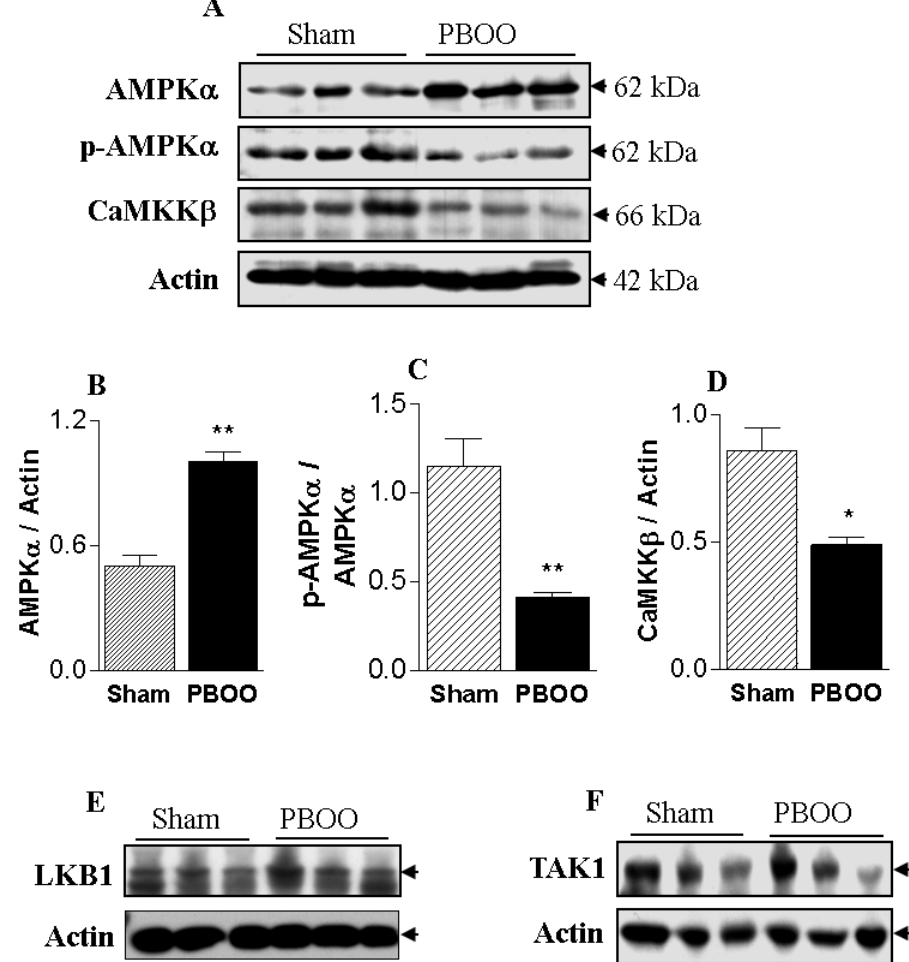
Figure 2. Effect of partial bladder outlet obstruction (PBOO) on AMPKα expression ( A , B ), AMPKα phosphorylation ( A , C ), CaMKKβ expression ( A , D ), and expression and phosphorylation of LKB1 ( E ) and TAK1 ( F ) in bladder tissue. The expression level of AMPKα increased significantly in response to PBOO, whereas the phosphorylation level, indicating AMPK activity, and CaMKKβ expression decreased significantly. *: p < 0.05 and **: p < 0.01, compared to sham.